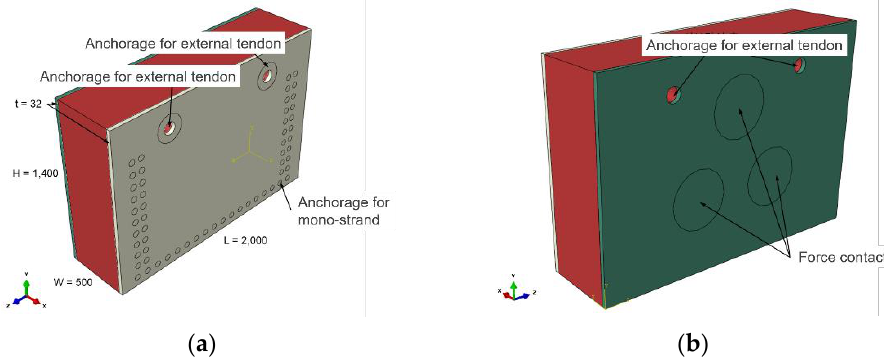
Figure 10. Anchor block modeling for ( a ) reaction (front) side and ( b ) forcing (rear) side.